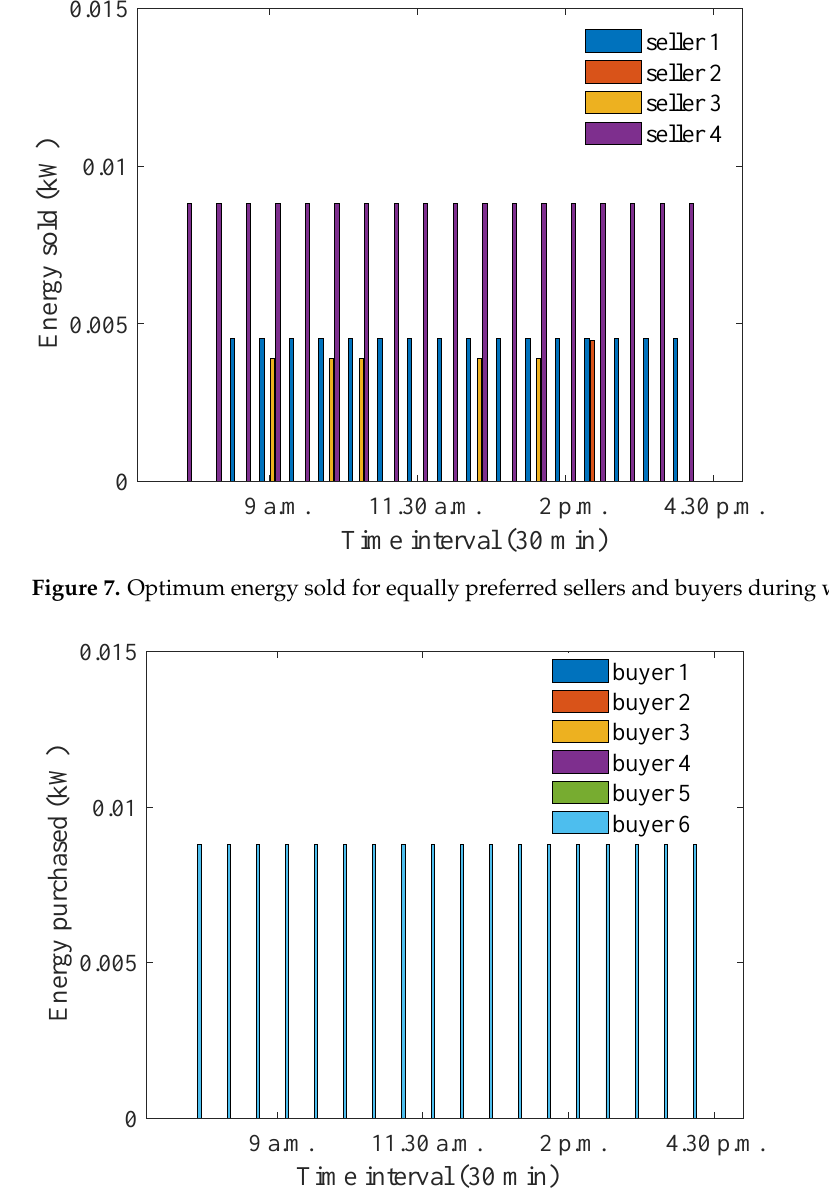
Figure 8. Optimum energy purchased for equally preferred sellers and buyers during winter